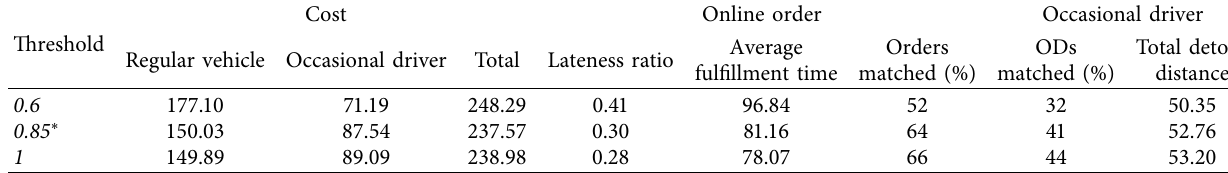
Table 7: Impact of the OD compensation threshold.